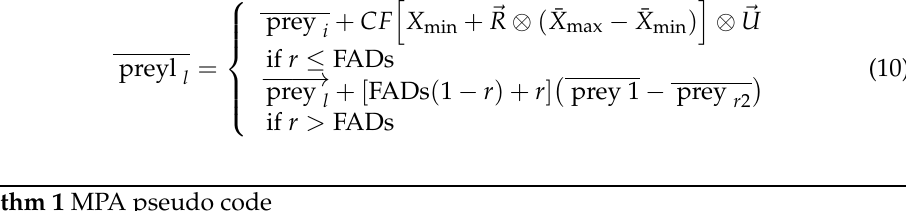
Algorithm 1 MPA pseudo